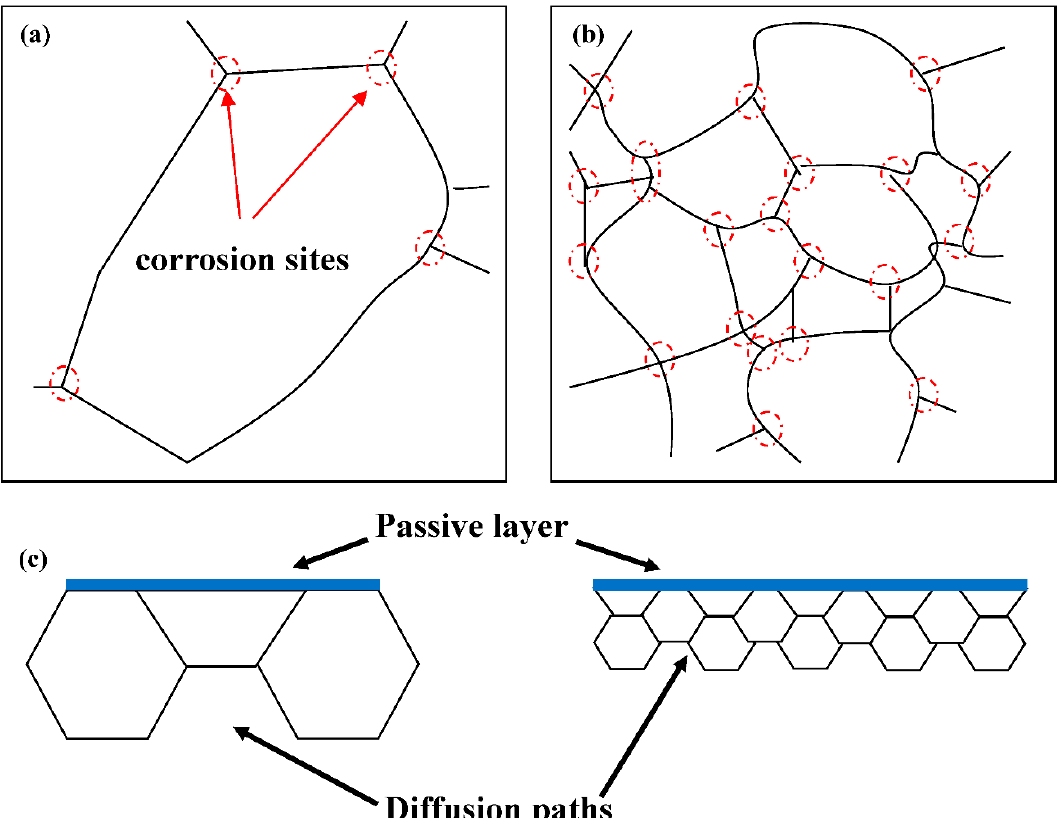
Figure 11. Schematic of the effect of grain size on corrosion properties of weld joint. ( a ) the surface of large grain, ( b ) the surface of small grain and ( c ) the cross-section of large and small grains